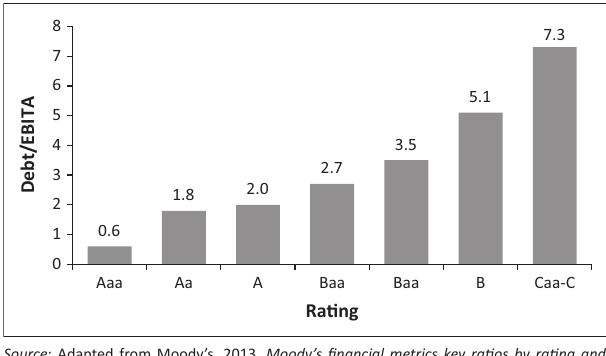
FIGURE 1: Debt/EBITDA by rating